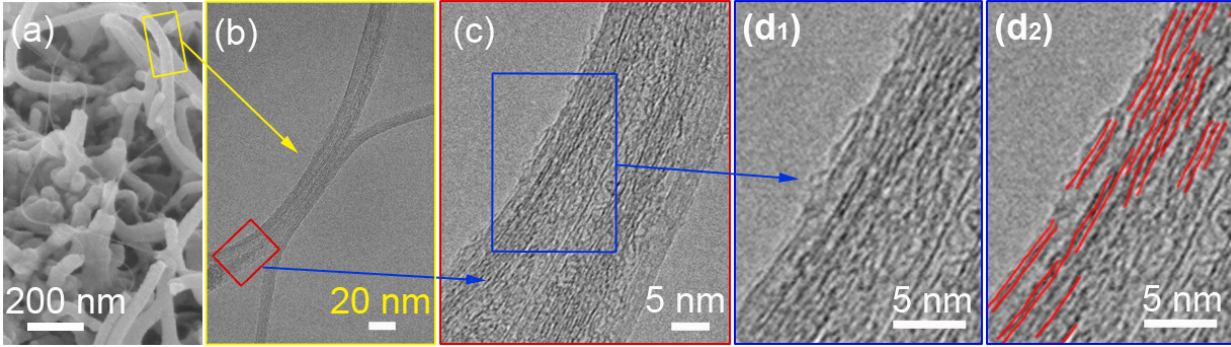
) show an area 1 ) a 2 ) 1